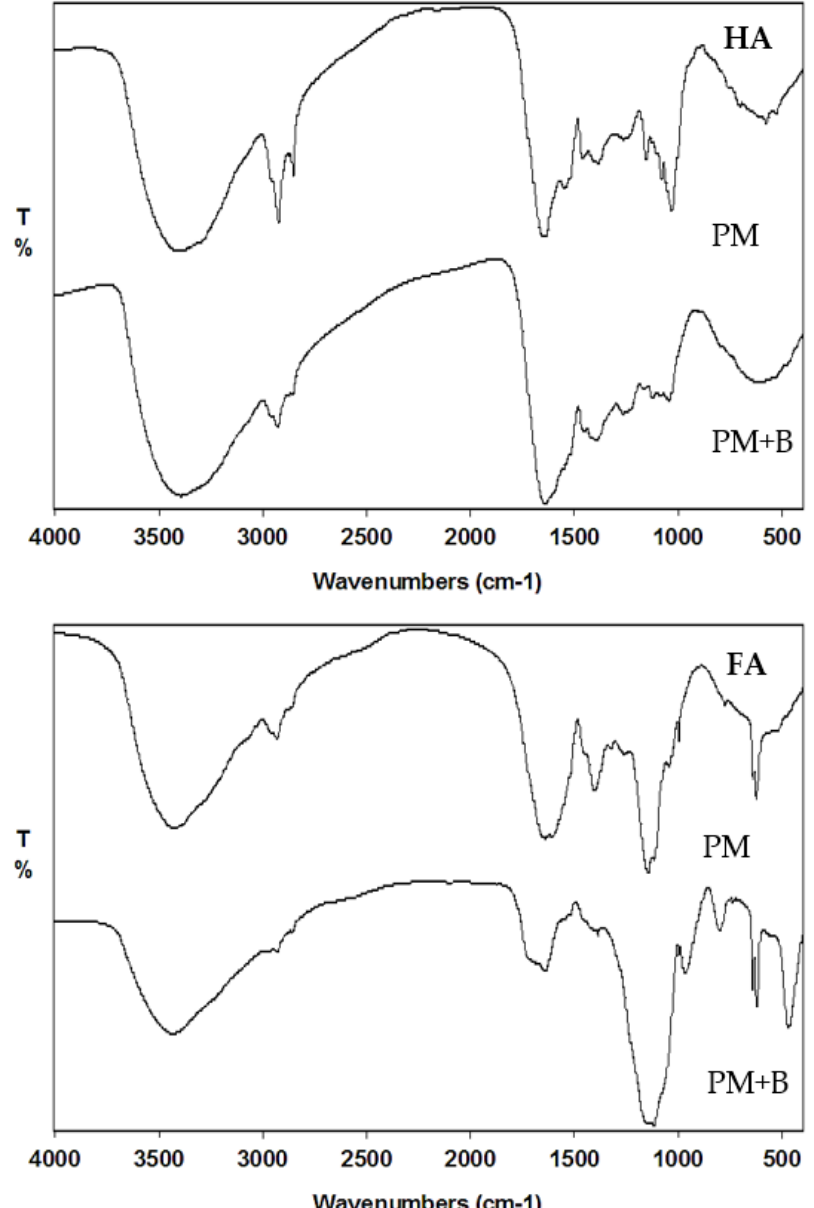
Figure 2. Fourier transformed infrared (FT-IR) spectroscopy of humic acid-like (HA) and fulvic acid-like (FA) extracted from poultry manure compost (PM) and poultry manure blended with biochar (PM+B).